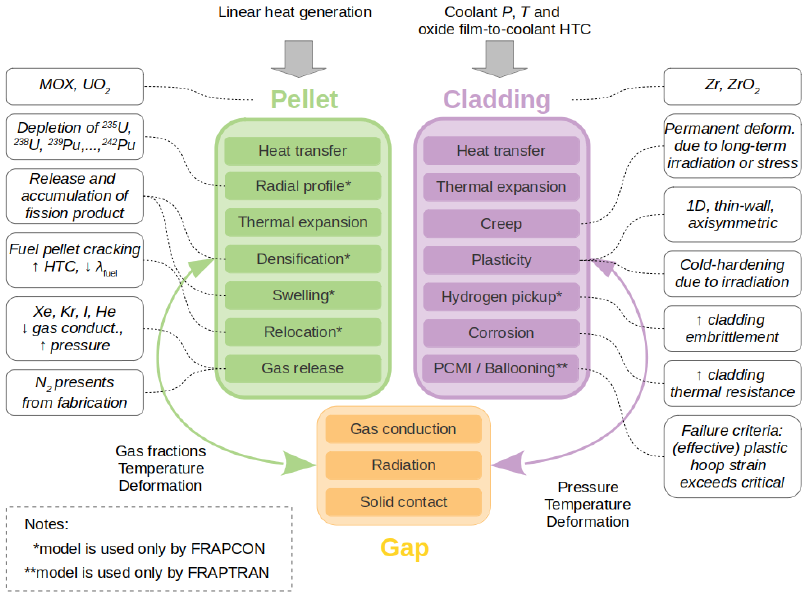
Figure 1. Fuel Rod Analysis Programming Interface (FRAPI)